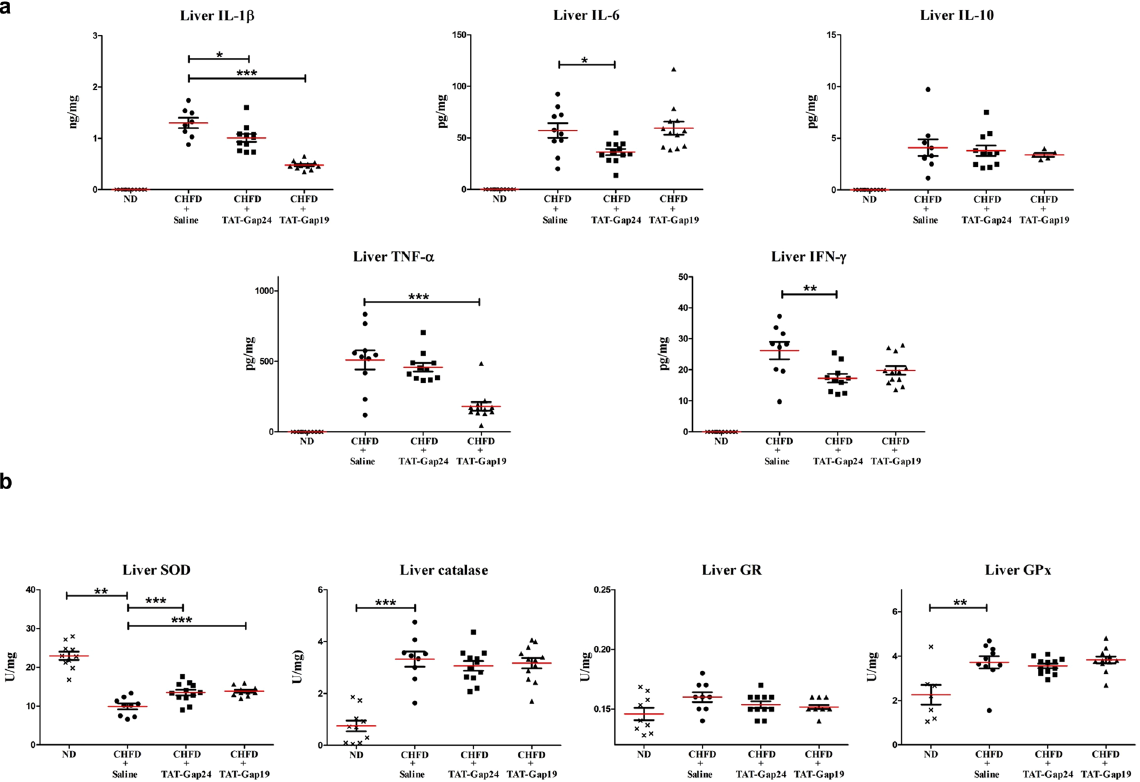
Figure 5. Effects of TAT-Gap24 and TAT-Gap19 on inflammatory cytokines and oxidative stress in NASH. After 8 weeks of CHFD, an osmotic pump was surgically implanted in the abdominal cavity, which ensured sustained release of 1 mg/kg/day TAT-Gap24 (n = 11) or TAT-Gap19 (n = 12) or saline (n = 14) for another 2 weeks while continuing the diet. ( a ) Levels of IFN- γ , IL-6, IL-1 β , TNF- α and IL-10 in liver tissue and serum. ( b ) Activity of SOD, GR, GPx and catalase in liver tissue. Data are expressed as means ± SEM with * p < 0.05, ** p < 0.01, and *** p <